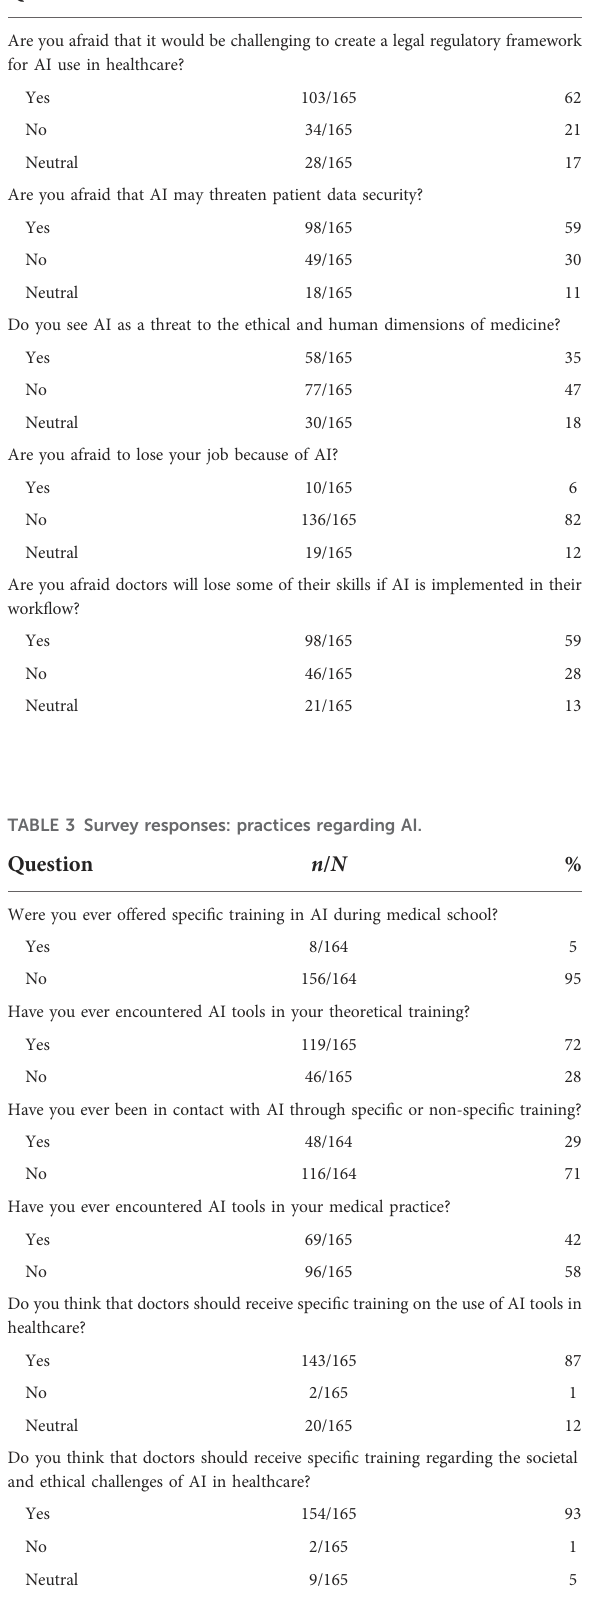
TABLE 2 Survey responses: fears toward